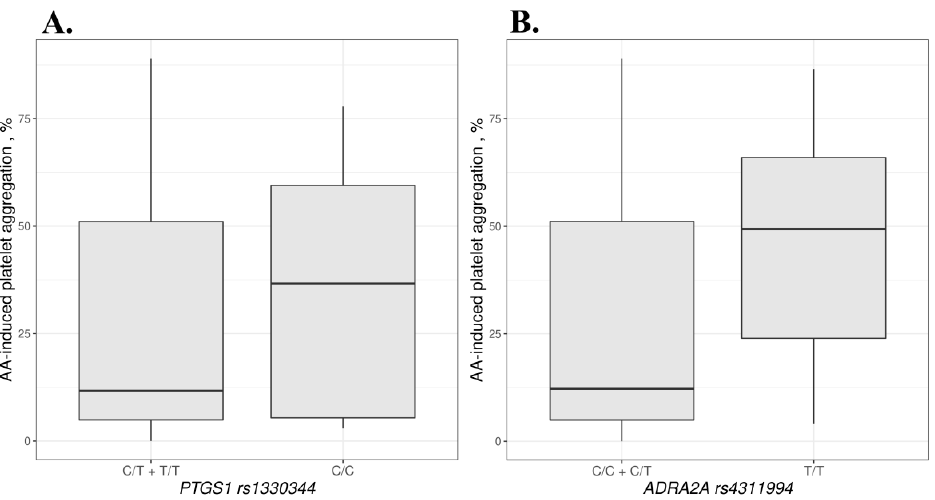
Figure 2. AA-induced aggregation based on the PTGS1 rs1330344 ( A ) and ADRA2A rs4311994 ( B ) genotypes.